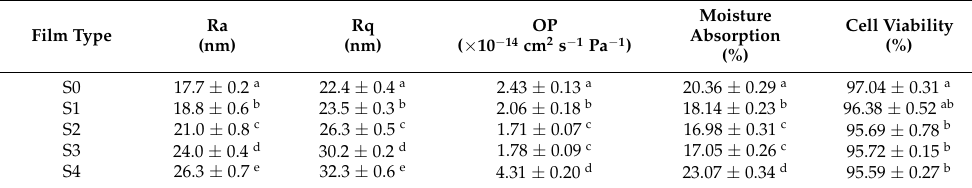
Table 2. Roughness parameters, barrier properties, moisture absorption and cell viability of active films with different RCAE